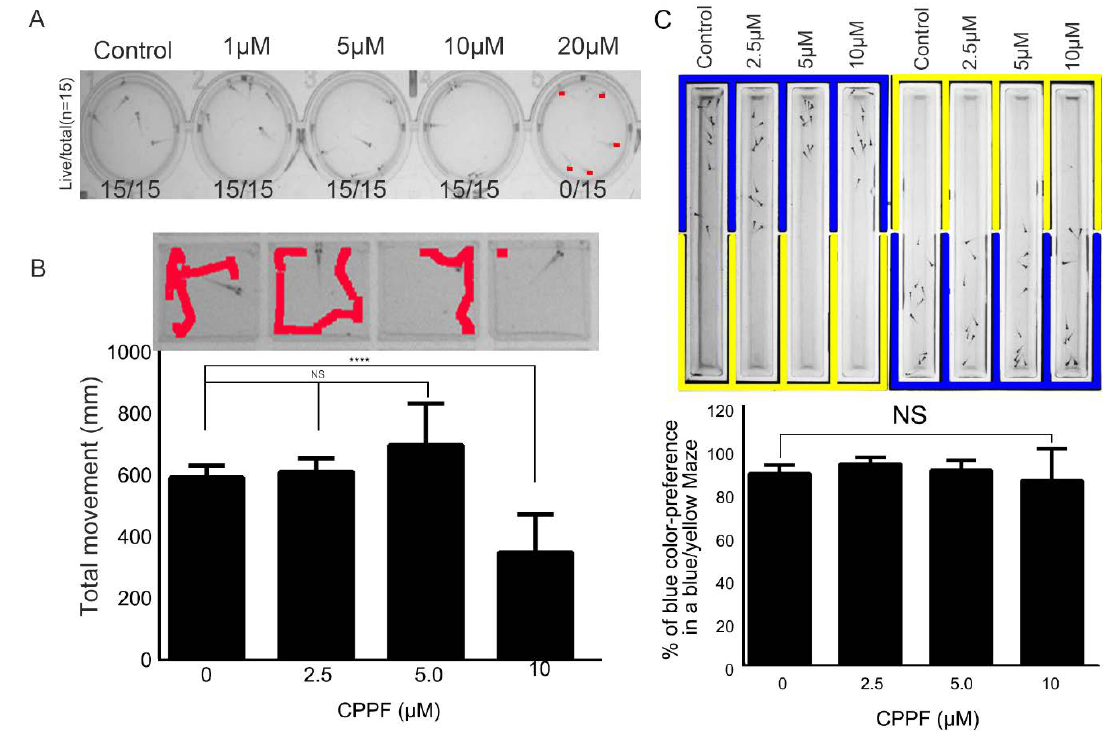
Figure 6. CPPF has low toxicity in zebrafish. ( A ) Five DPF zebrafish were incubated in a 12-well plate and treated with various concentrations of CPPF. After 24, 48 and 72 h, images were captured and analyzed to determine survival ( n = 15); ( B ) Five DPF zebrafish were incubated in a 96-well plate and treated with various concentrations of CPPF. After 1 h adaptation, the zebrafish movements were recorded for 4 h ( n = 6). The total distance traveled was measured by Ethovision software. Error bars represent means ± SD of 6 fish movement, **** p -value < 0.0001 and NS: Not significant; ( C ) Five DPF zebrafish were incubated in a blue-yellow chamber and treated with 0, 2.5, 5 or 10 µ M CPPF. After 1 h in the dark, zebrafish were exposed to 123 lux of light for 1 h and record. At 10 min interval, the location and number of fish were logged. Error bars represent means ± SD of 20 fish movement, NS: Not significant.